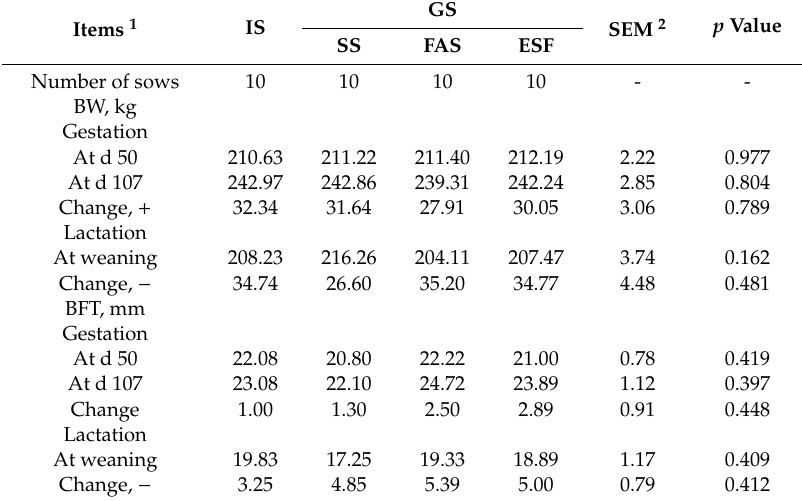
Table 2. E ff ects of individual stalls (IS) and group housing systems (GS) on sow